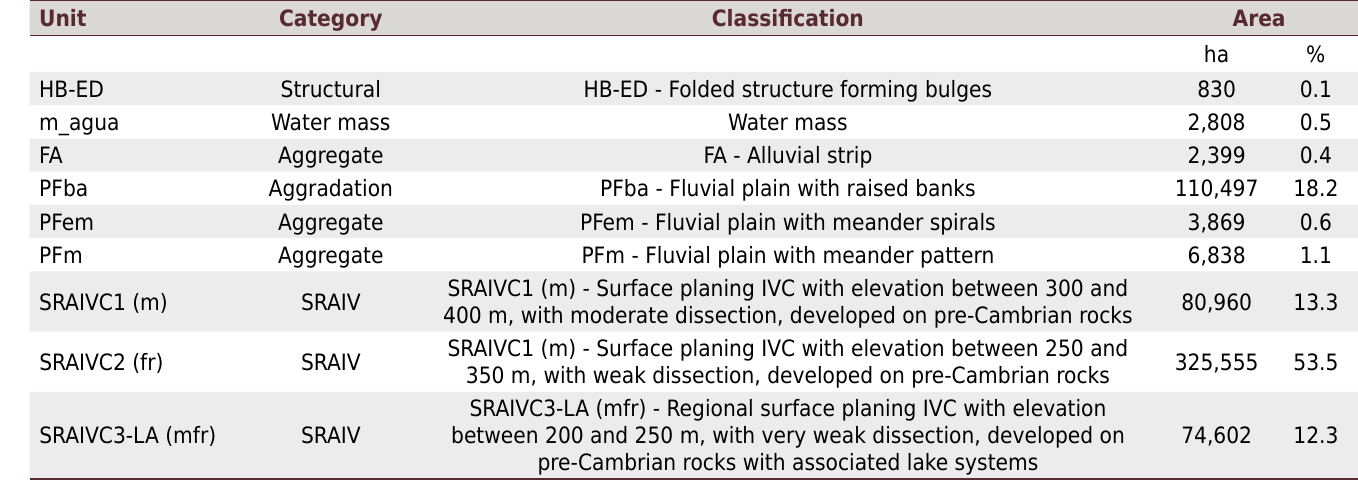
Table 2. Description of the geomorphologic units of the municipality of São Miguel do Araguaia, state of Goiás, Brazil